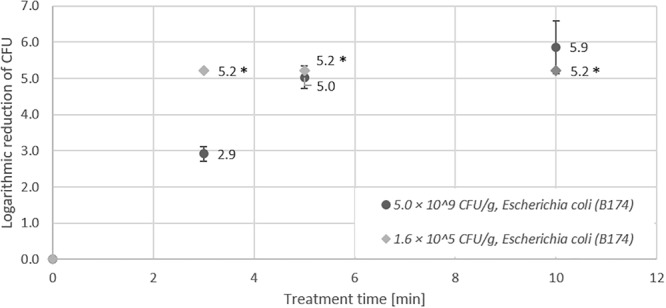
Effect of CAPP treatment of E. coli B174 on lentil seeds. Inoculation was performed either as high initial inoculation (5.0 × 109 CFU/g) or low initial inoculation (1.6 × 105 CFU/g) prior to treatment of seeds for 3, 5, or 10 min in the DCSBD. Logarithmic reductions were represented as log10 CFU/g ± standard deviation. The limit of detection was 10 CFU/sample for low initial inoculation and 100 CFU/sample for high initial inoculation. Logarithmic reduction below the limit of detection is indicated by an asterisk.